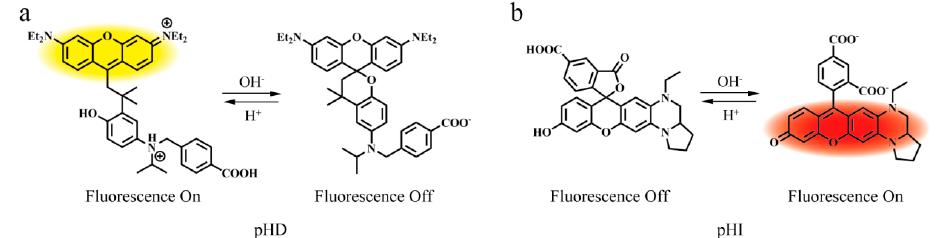
Figure 1. Structure and proposed mechanism of ( a ) pHD and ( b ) pHI.